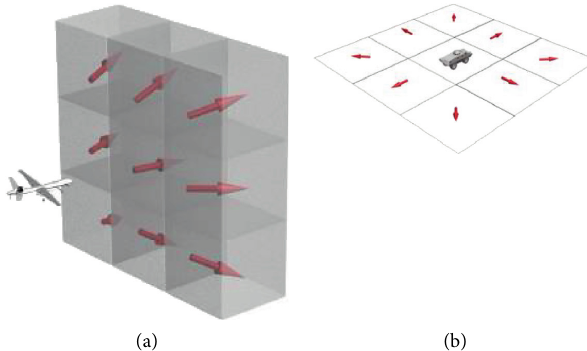
Figure 3: Set of adjacent grids. (a) Adjacent grid of P